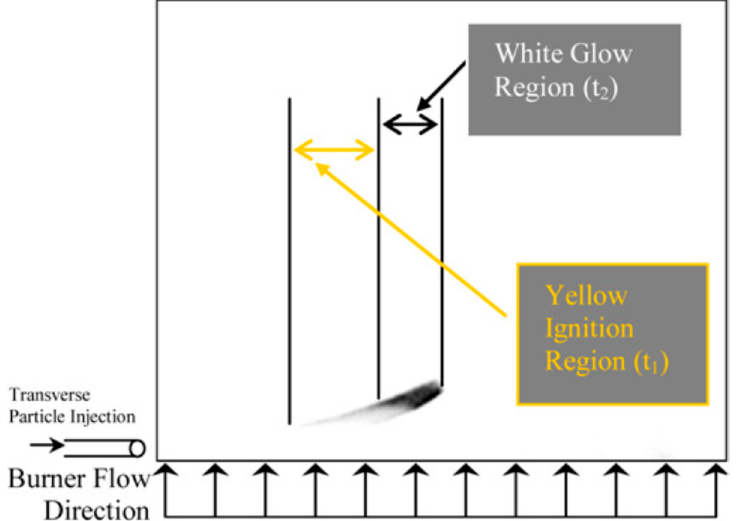
Figure 15. Unfiltered image of SB99 nanopowder combustion. Reproduced from [9], with permission from Elsevier, 2009.